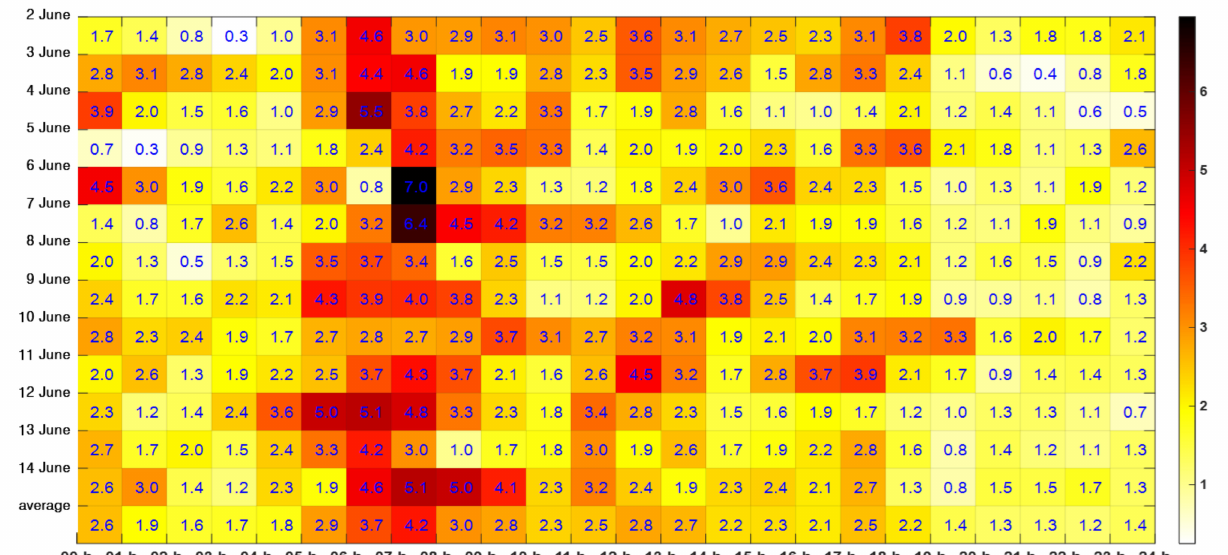
Figure 5. Scatter plot for the near-miss location between merchant vessels and non-merchant vessels in Yeosu VTS area; head-on ( red square ), crossing ( blue triangle ), overtaking situation ( yellow circle ), merchant vessels trajectories ( cyan dotted line ), and non-merchant vessel trajectories ( magenta dotted line ).